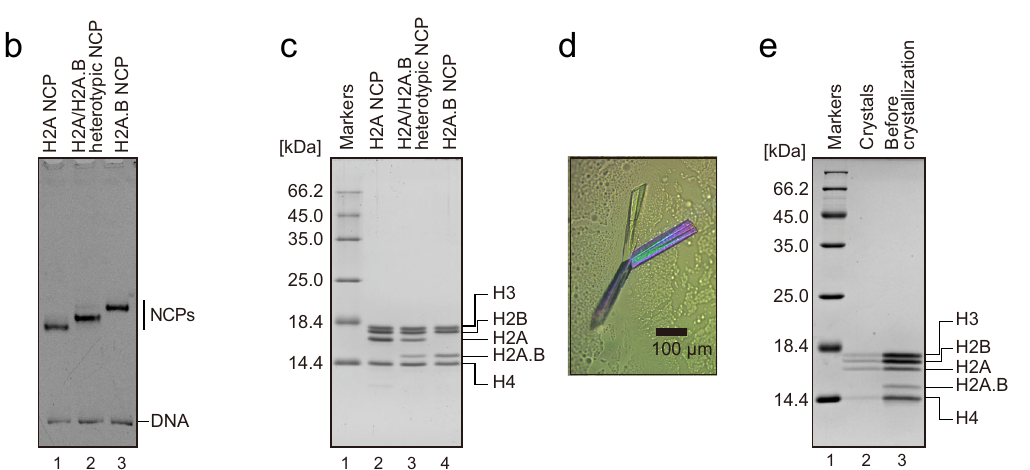
Fig. 1 Crystallization of the H2A.B/H2A heterotypic NCP. a Sequence alignment of H2A, H2A.B, H2A.Z, and H2A.X. The speci fi c residues of H2A.B, H2A. Z, and H2A.X, as compared with H2A, are colored blue, orange, and green, respectively. Dashes indicate gaps in the alignment. The C-terminal region of H2A (enclosed in the red square) is replaced with that of H2A.B (enclosed in the red square), in the chimeric protein shown in Fig. 5a and Supplementary Fig. 5. (a, b) The puri fi ed NCPs were analyzed by native-PAGE with ethidium bromide staining ( b ) and SDS-PAGE with Coomassie Brilliant Blue (CBB) staining ( c ). d The crystals obtained in the presence of the H2A.B/H2A heterotypic NCP (see “ Methods ” ). e Histones in the crystals (lane 2) and in the solution of the H2A.B/H2A heterotypic NCP (lane 3) were analyzed by SDS-PAGE with CBB staining. The uncropped gel images are shown in Supplementary Fig.